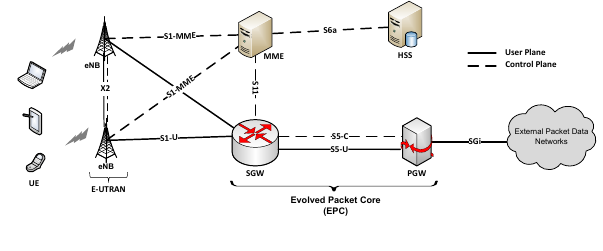
Figure 1. The LTE/EPC architecture The EPC consists in four network elements namely Serving Gateway (SGW), PDN Gateway (PGW), Mobil- ity Management Entity (MME), and Home Subscriber Server (HSS) [17]. The UE connects to eNB, the eNB directs data tra ffi c to SGW and PGW in a GTP tunnel and for the control tra ffi c it directs to MME. The